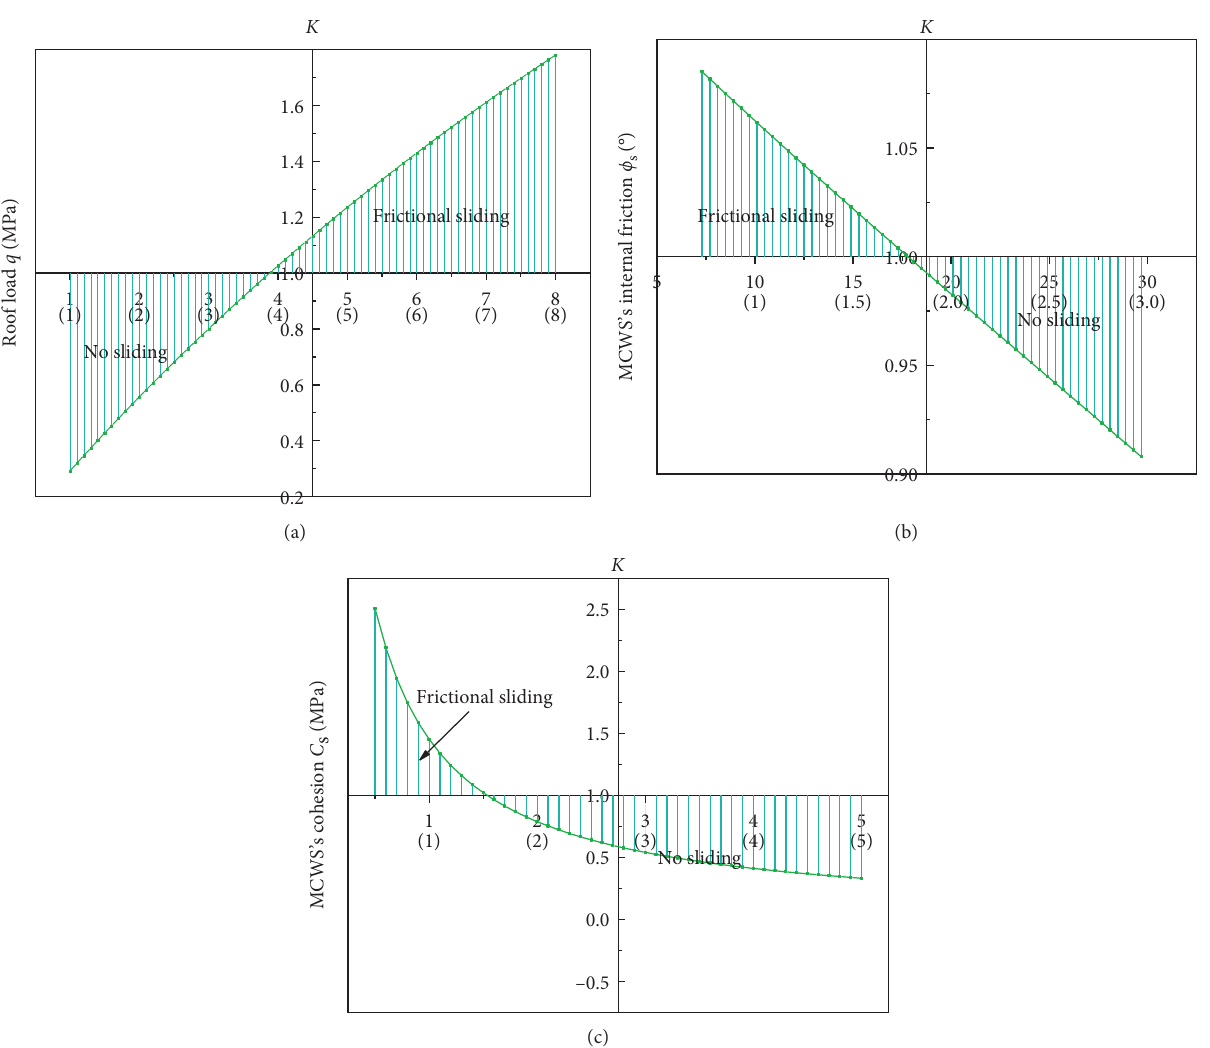
Figure 10: The impact of the main factors on frictional sliding of the slip body. (a) The impact of roof load q on K . (b) The impact of the MCWS friction angle φ s on K . (c) The impact of MCWS’s cohesion C s on K